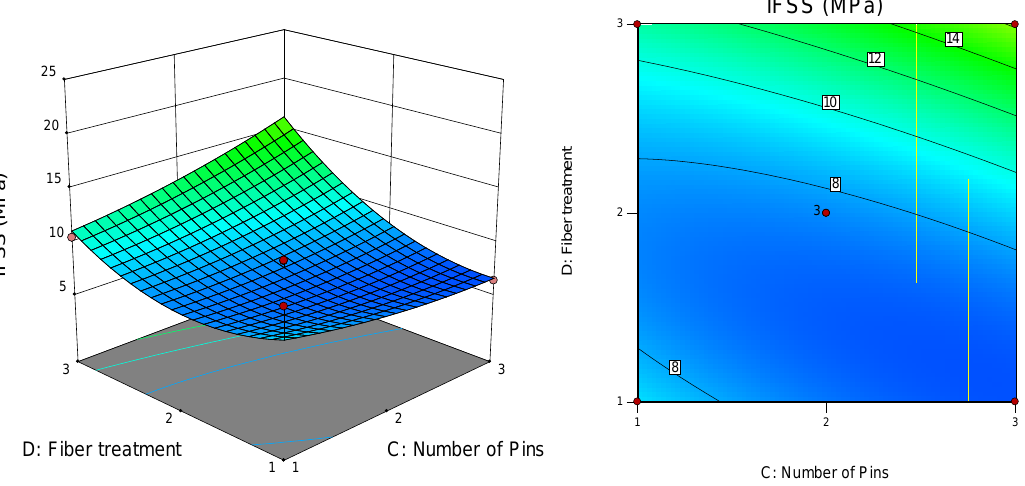
Figure 15. Interaction effect between fibre treatment and number of pins on IFSS.